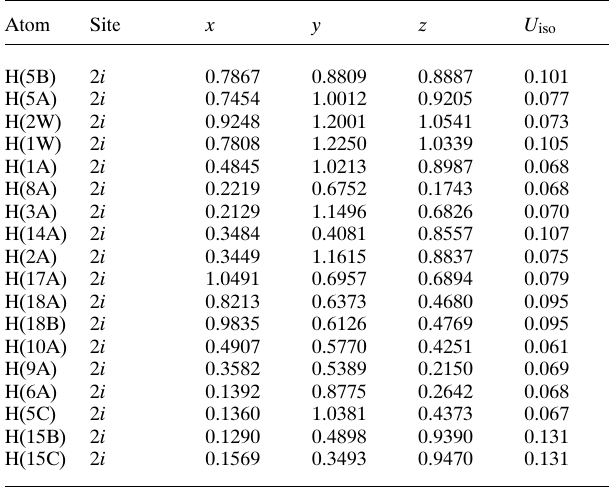
Table 2. Atomic coordinates and displacement parameters (in Å 2 ) .